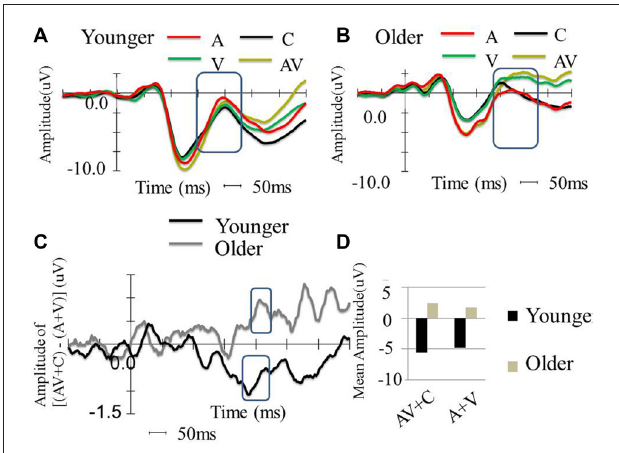
FIGURE 6 | Larger behavioral benefits were related to greater neural integration in multisensory condition in older participants. Behavioral benefit in multisensory integration was indexed by the average of the V benefit [IES (AV-A)] and the A benefit [IES(AV-V)]. Neural integration of multisensory information was indexed by (AV + C) − (A + V) of P2 amplitudes in FC2. Older participants with larger behavioral benefits (more negative values) also showed greater super-additive neural integration (more positive values; squares). However, in younger participants, the degree in behavioral benefit was marginally related to the degree of neural integration